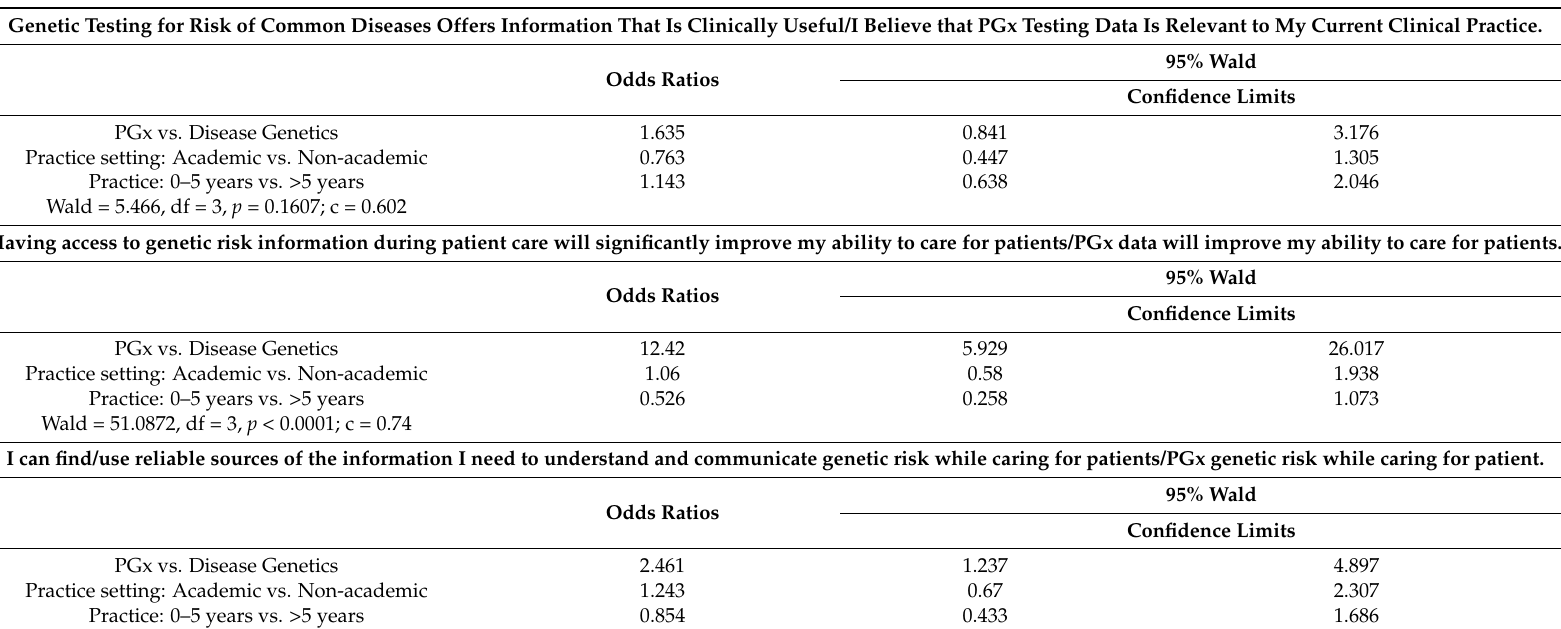
Table 4. Multivariable logistic regression models predicting physician agreement to the following